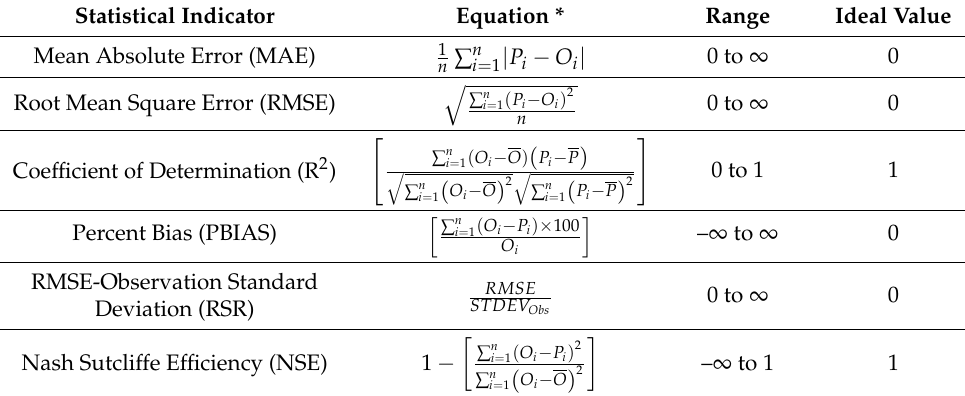
Table 2. Summary of Statistical Indicators Equations and Ranges [63,64].